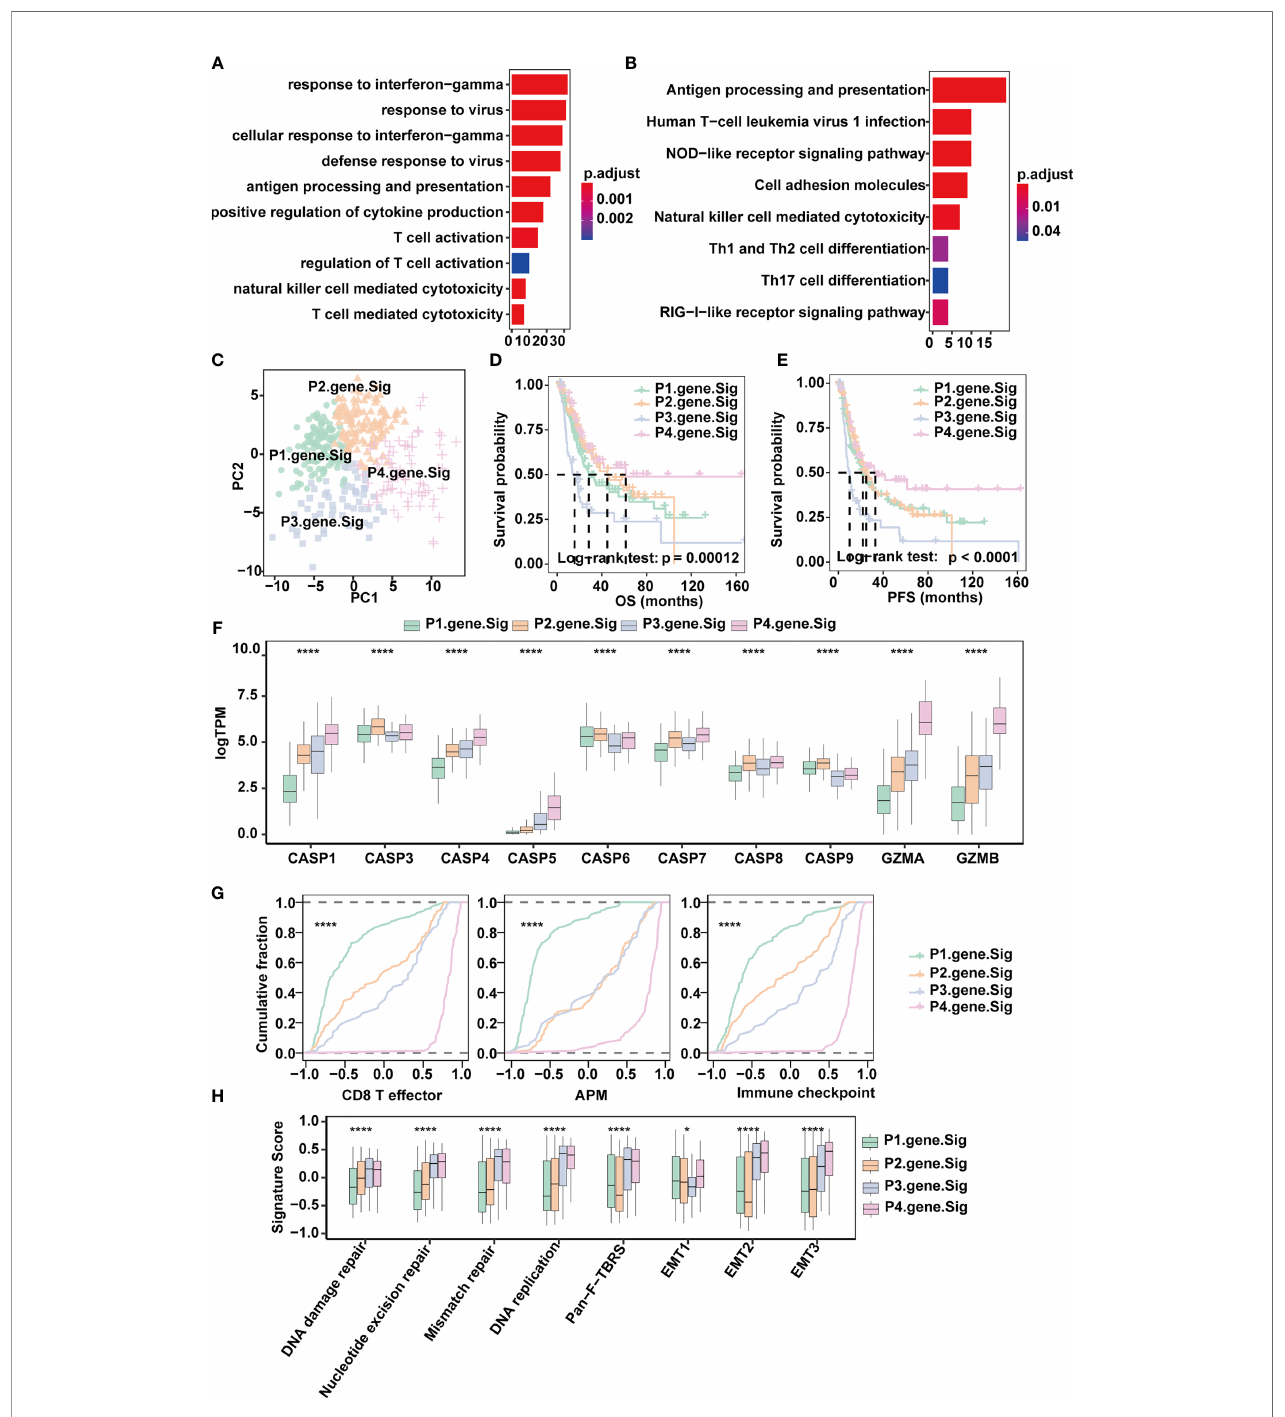
FIGURE 4 | Classi fi cation of MIBC subtypes based on pyroptosis signatures in the TCGA-MIBC cohort. (A) Enrichment of GO terms and number of genes involved in pyroptosis-related signature genes. (B) Enrichment of KEGG pathways and number of genes involved in pyroptosis-related signature genes. (C) Principle components built based on the expression of the 57 pyroptosis-related signature genes. (D) Overall survival analysis for the four pyroptosis gene signatures. (E) Progression-free survival analysis for the four pyroptosis gene signatures. (F) Boxplots depicting the differences in pyroptosis enzyme expression between the four pyroptosis gene signatures in the TCGA-MIBC cohort. The asterisks represent the statistical P value (*p < 0.05; ****p < 0.0001). (G) Cumulative distribution function showing the four pyroptosis gene signatures were distinguished by different signatures (CD8T effector, APM, and Immune checkpoint as indicated) in the TCGA-MIBC cohort. (H) Boxplots depicting the four pyroptosis gene signatures were distinguished by different signatures (mismatch-relevant signature and stromal-relevant signature as indicated) in the TCGA-MIBC cohort. The asterisks represent the statistical P value (*p < 0.05; ****p <